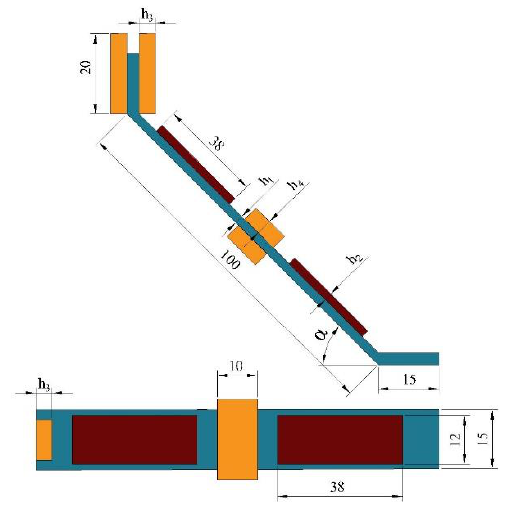
Figure 6. Diagram of the two-degree-of-freedom diagonal